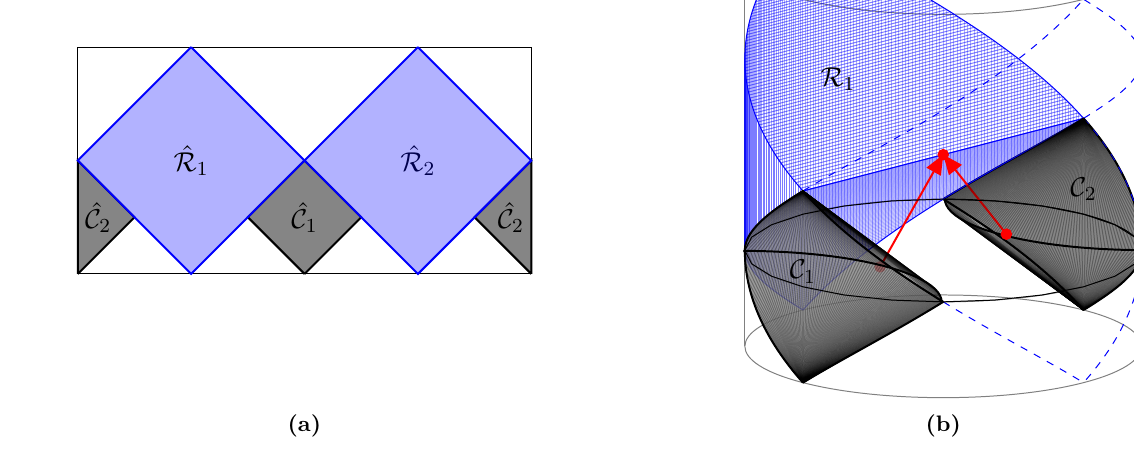
and output regions ˆ R . This particular i i defined by ˆ C = ˆ V . (b) Bulk perspective on the same choice of i i i and R . Only one of the out regions is shown, to avoid i i 12 → 12